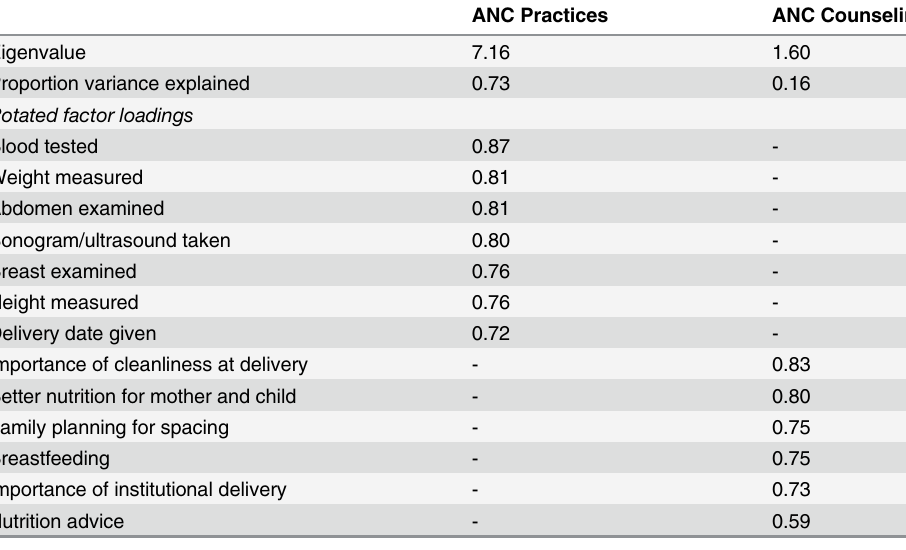
Table 1. Characteristics and rotated factor loadings for antenatal care factorsa a